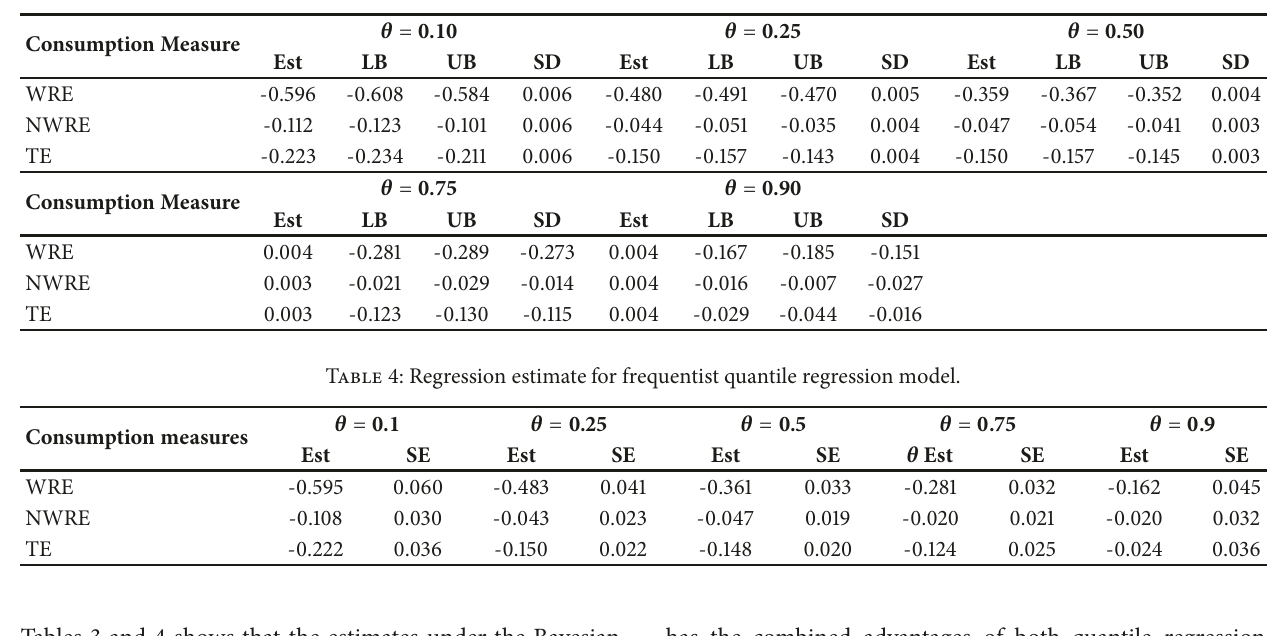
Table 3: Regression estimate for Bayesian quantile regression model.